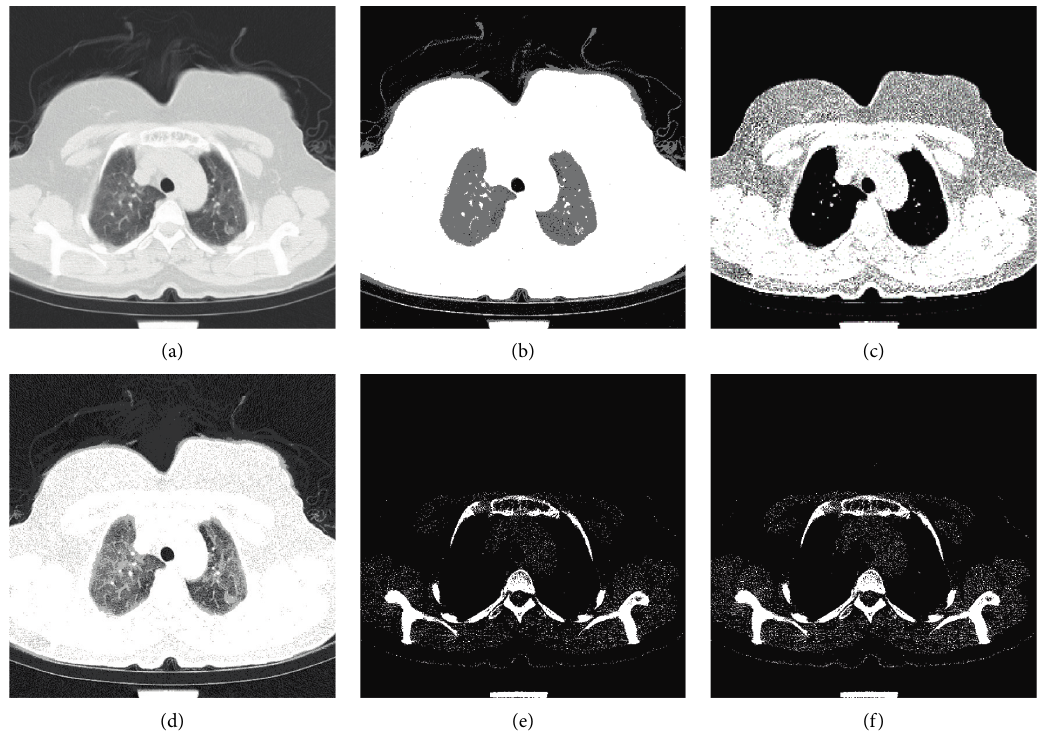
Figure 13: The comparison outcomes. (a) Original CTimage-6; (b–d) segmentation result of threshold levels 2,3, and 4, respectively, of the proposed approach; (e) segmentation results obtained by Tao [21]; (f) segmentation results obtained by Tang [22].